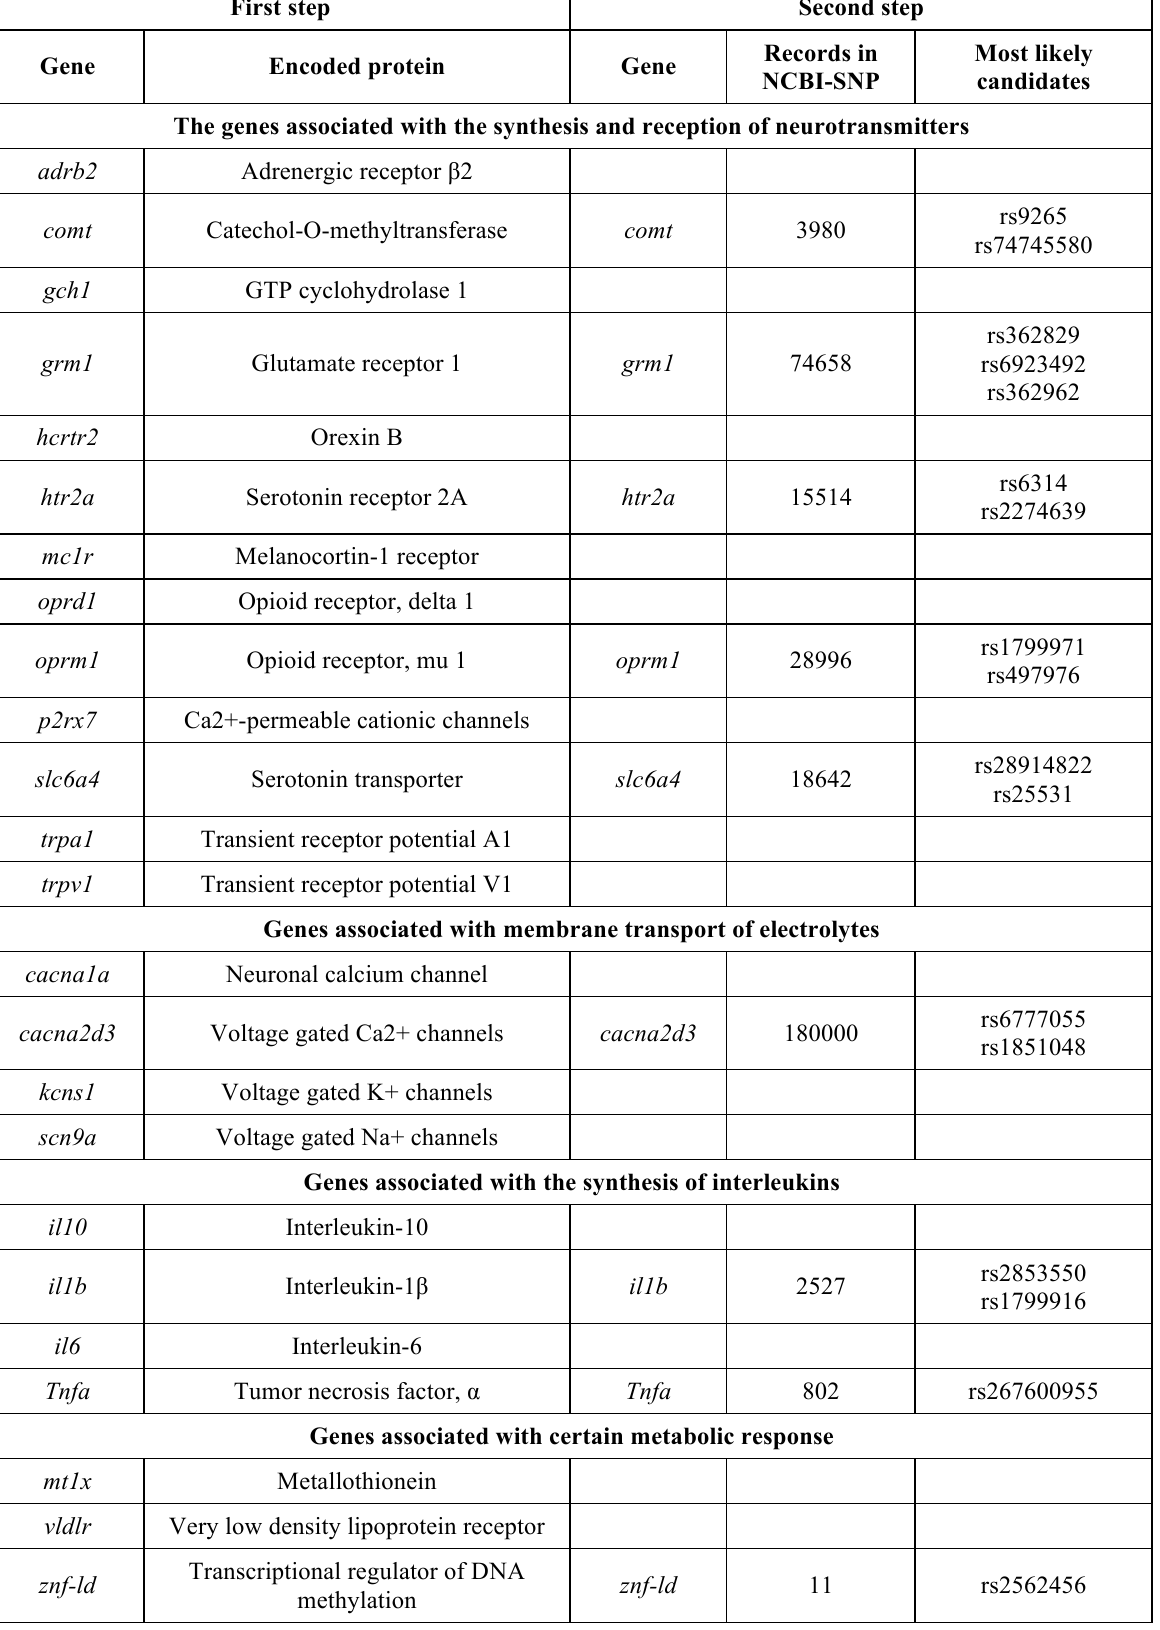
Table 1: The list of genes and selected genetic polymorphisms associated with phenotypic characteristics of pain perception and reactive response to the pain perception in human First